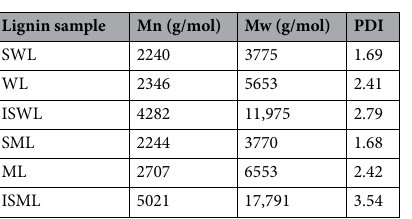
Table 1. Mn, Mw, and PDI corresponding to the lignin and